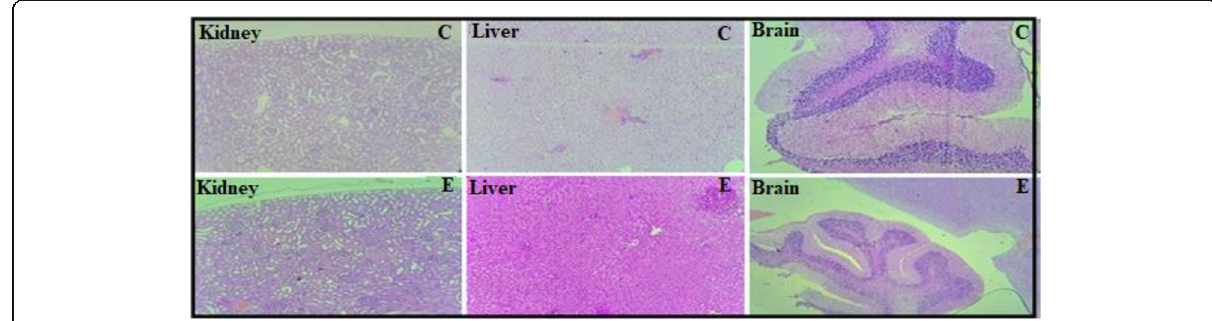
Fig. 5 Histopathological sections of the kidney, liver, and brain of control and group treated with a mixture of natural compounds